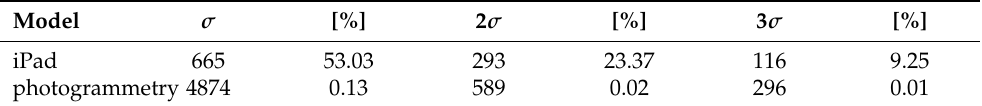
Table 2. Analysis of the number of outlying points ( σ = Q 3 = 1.5 [mm]) for fine